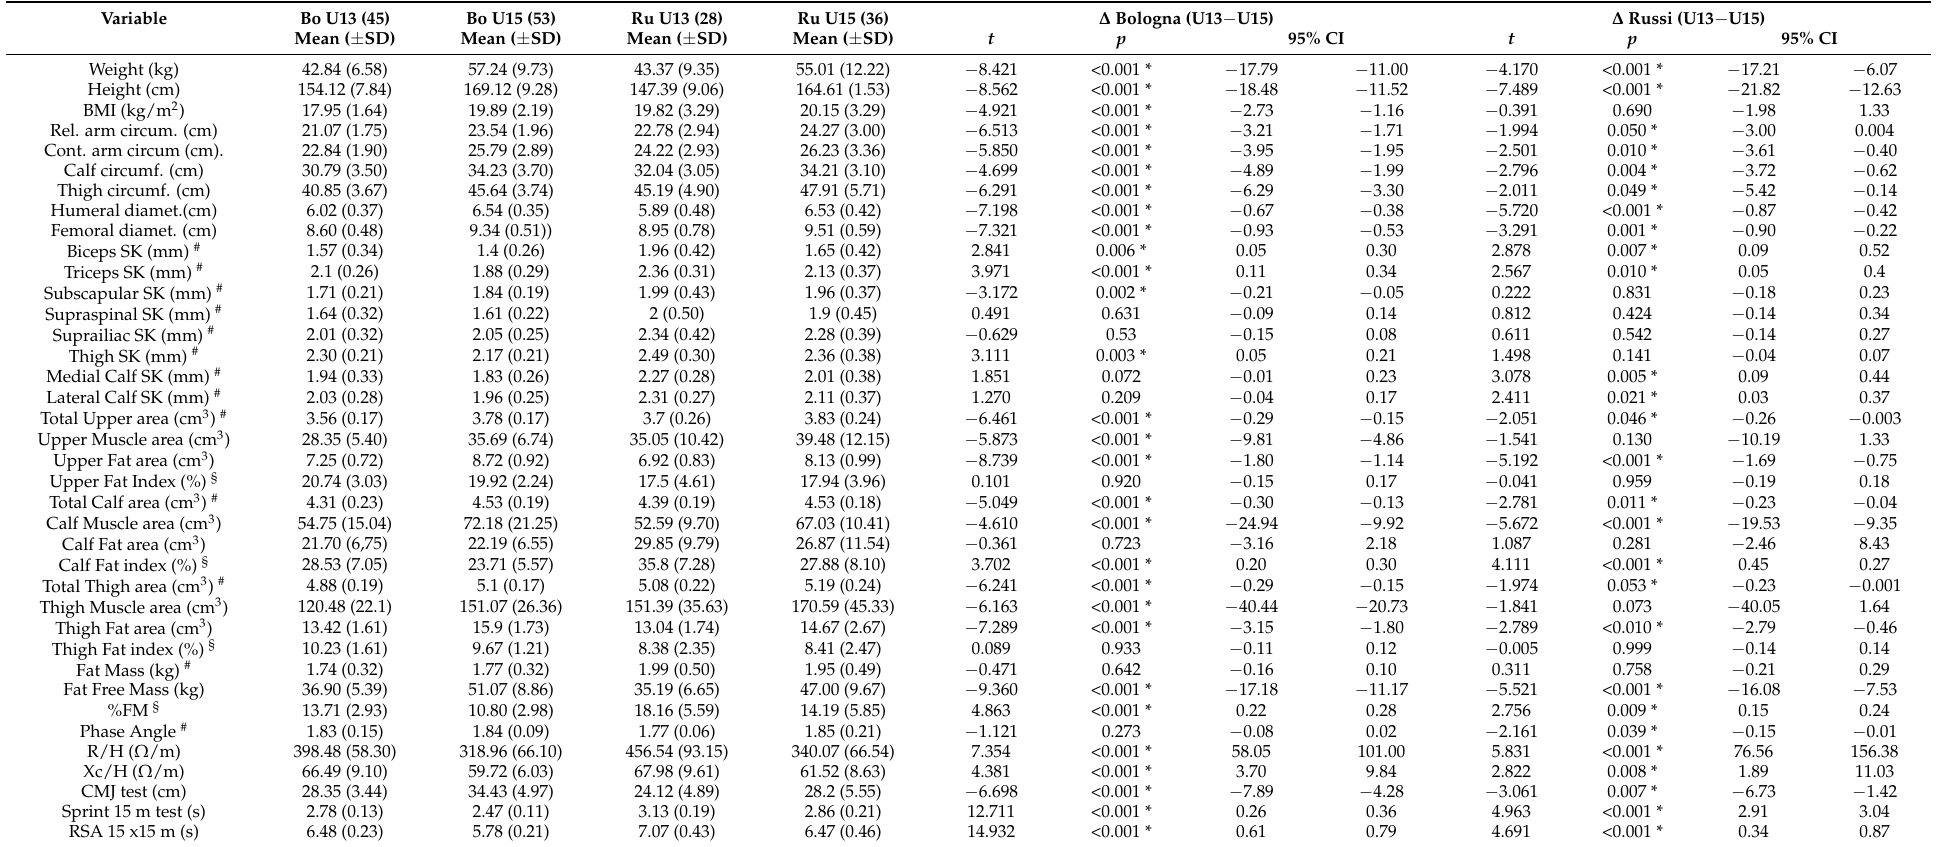
Table 2. Mean differences among U13 and U15 categories of each